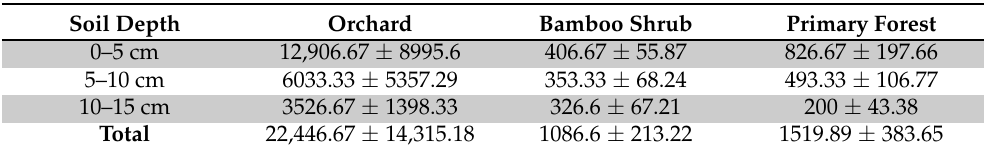
Table 4. Average soil seed bank density (m 2 ; mean ± standard deviation) of each vegetation type in different soil